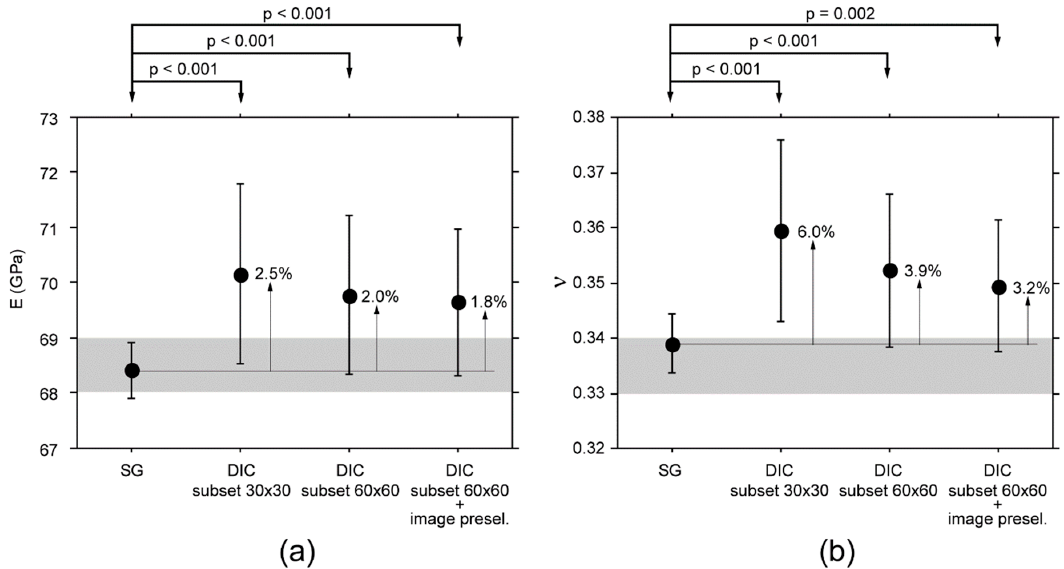
Figure 7. ( a ) E and ( b ) ν mean values, and relative standard deviations, determined using SG and DIC technique. The grey bands represent the range of E and ν values for AA1050, as reported in the literature. Note: The total sample size is 25, with 5 repeated measurements taken on the same specimen.